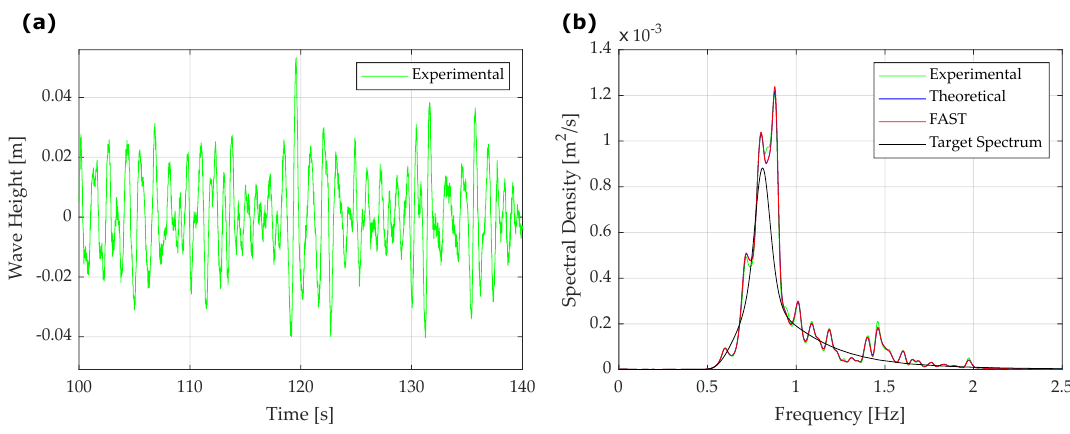
Figure 6. ( a ) The mean wave height data measured by the four wave gauges. ( b ) The wave spectra calculated from experimental and simulated wave height data. The black wave spectrum was the target wave spectrum for AwaSys to generate in the wave